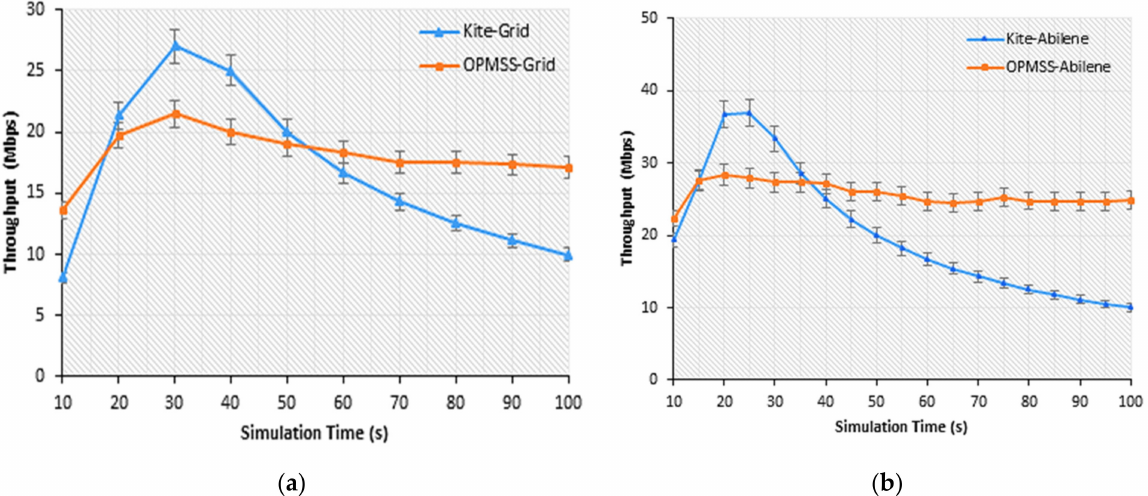
Figure 10. ( a ) Throughput vs. simulation time in the grid scenario, ( b ) Throughput vs. simulation time in the Abilene